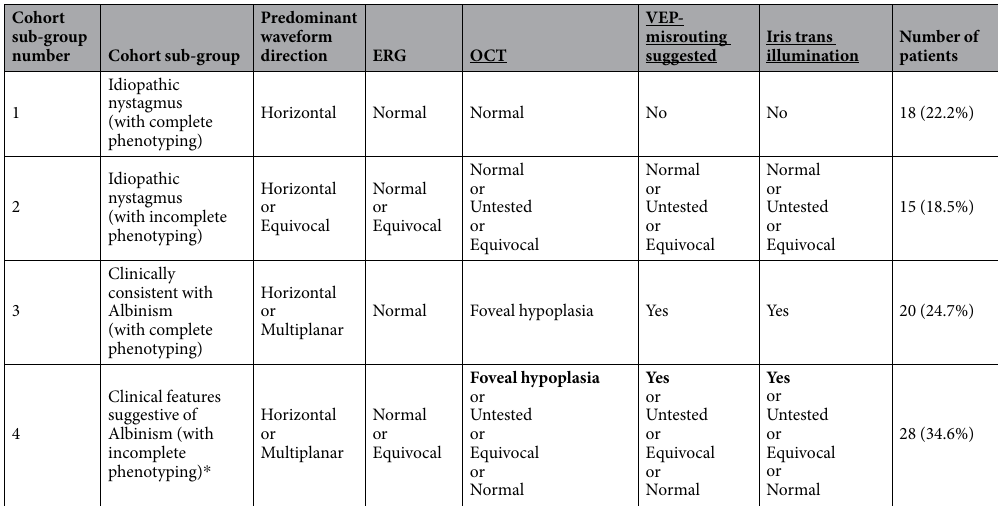
Table 1. Selection criteria of the four, clinically relevant phenotype sub-groups. Equivocal results were those deemed insufficient to permit calling typically due to limited patient compliance or borderline responses for example crossed asymmetry identified on only a few runs of monocular VEP testing (as is commonly the case in patients with hypomorphic albinism). * Must include at least one of the features